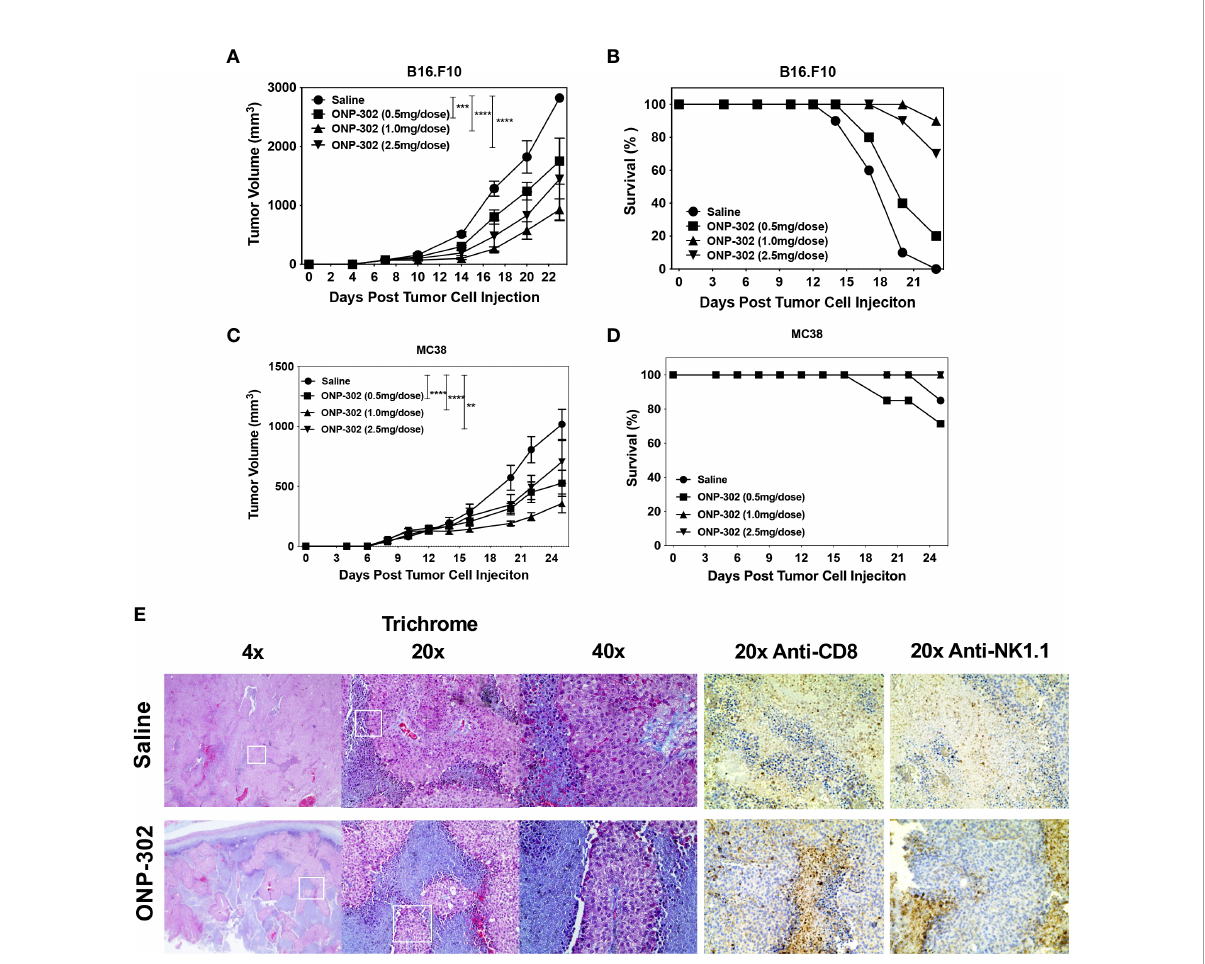
FIGURE 4 ONP-302 treatment decreases B16.F10 and MC38 tumor growth and increases tumor necrosis. Naïve female C57BL/6 mice (n = 7-10 per treatment group) were injected s.c. was B16.F10 (A, B) or MC38 (C, D) tumor cells. When the tumors were 50-100 mm 3 in size, mice were randomized and treated every three days with saline or ONP-302 (0.5, 1.0, or 2.5 mg/dose in 200 m L of saline) via i.v. injection. Tumor volumes were measured on the indicted days, and the data are presented as the mean tumor volume ± S.E.M (A, C) . The overall survival of the mice within each treatment group is also presented (B, D) . Mice were euthanized when the tumor volume exceeded 1500 mm 3 . Representative micrographs of B16.F10 tumors collected from saline and ONP-302 (1.0 mg/dose) treated mice were stained for trichrome, anti-CD8, and anti- NK1.1 (E) . One representative experiment of two is presented. Asterisks (**, ***, ****) indicate a statistically signi fi cant difference as compared to untreated cells, p < 0.01, < 0.001, and < 0.0001